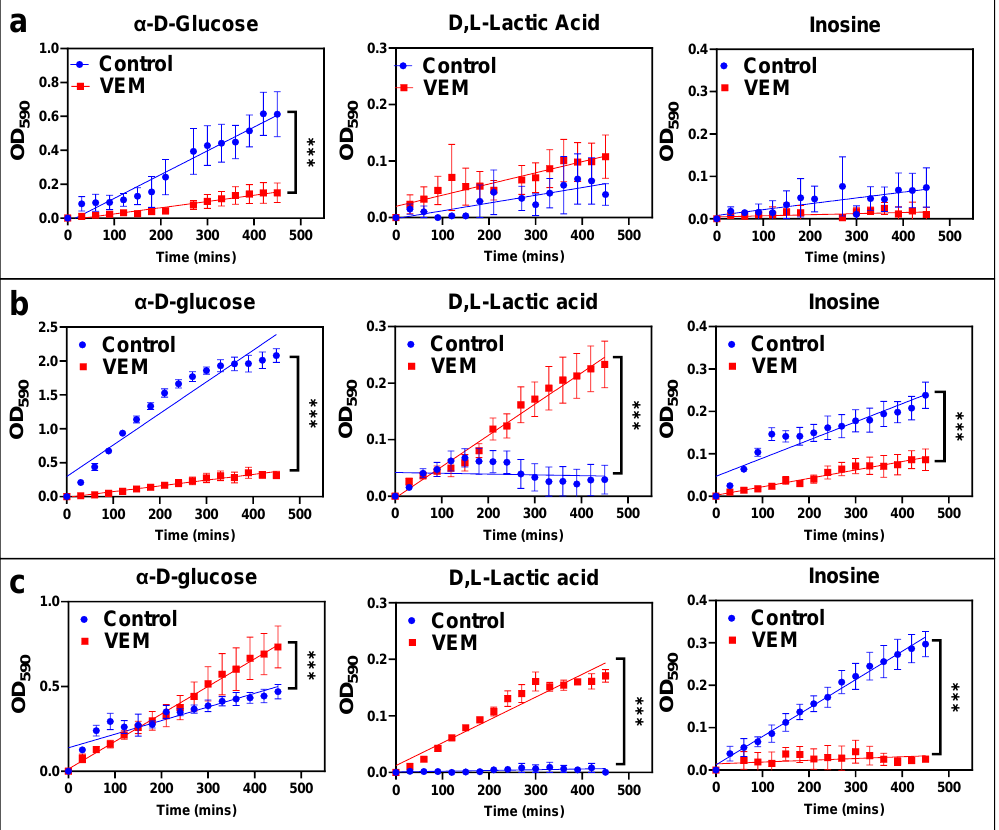
Figure 4. Assessing the consumption rates of various substrates in persister cells. Phenotype microarrays were used to measure the consumption rates of various substrates in VEM persister and control groups at ( a ) 0 h, ( b ) 24 h, and ( c ) 48 h. Consumption rates were measured with a tetrazolium-based dye at 590 nm (OD 590 ). The absorbance was normalized by using t = 0 h and glutamine control data (see Section 4). Data points and error bars represent the mean and the standard error, respectively. Statistical analysis was performed using a linear regression analysis (F-Statistics, *** p < 0.001). n = 4.